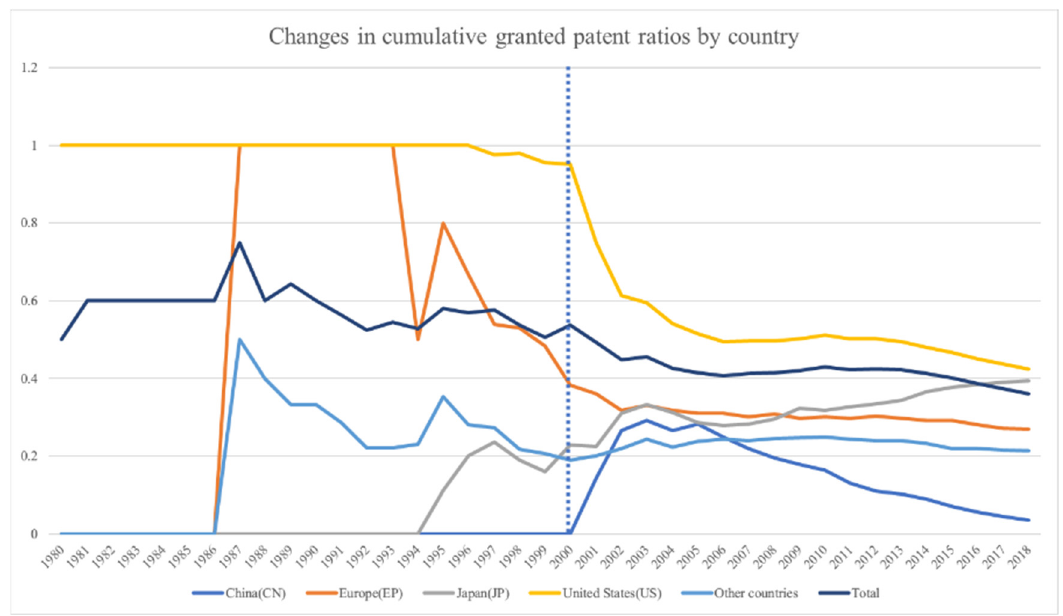
Figure 2. Yearly granted patent counts by country [35].